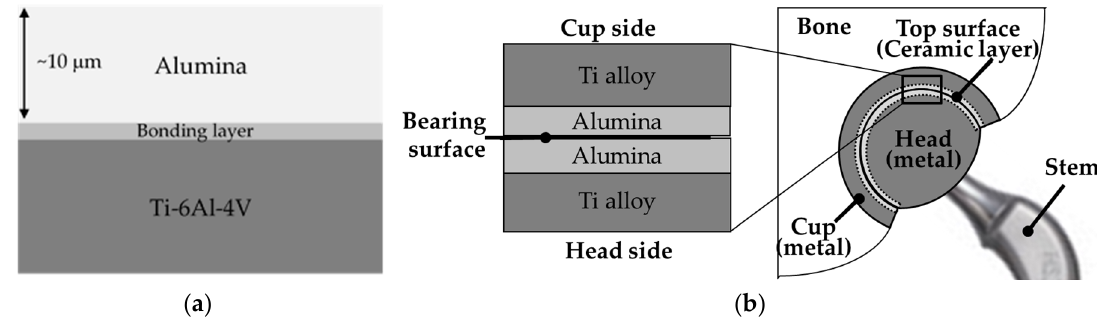
Figure 1. Cross-sectional views of alumina/Ti alloy (ATH) hybrid model ( a ), and ATH-on-ATH configuration of the artificial hip joint ( b ). Reproduced from [102] with permission from Elsevier.